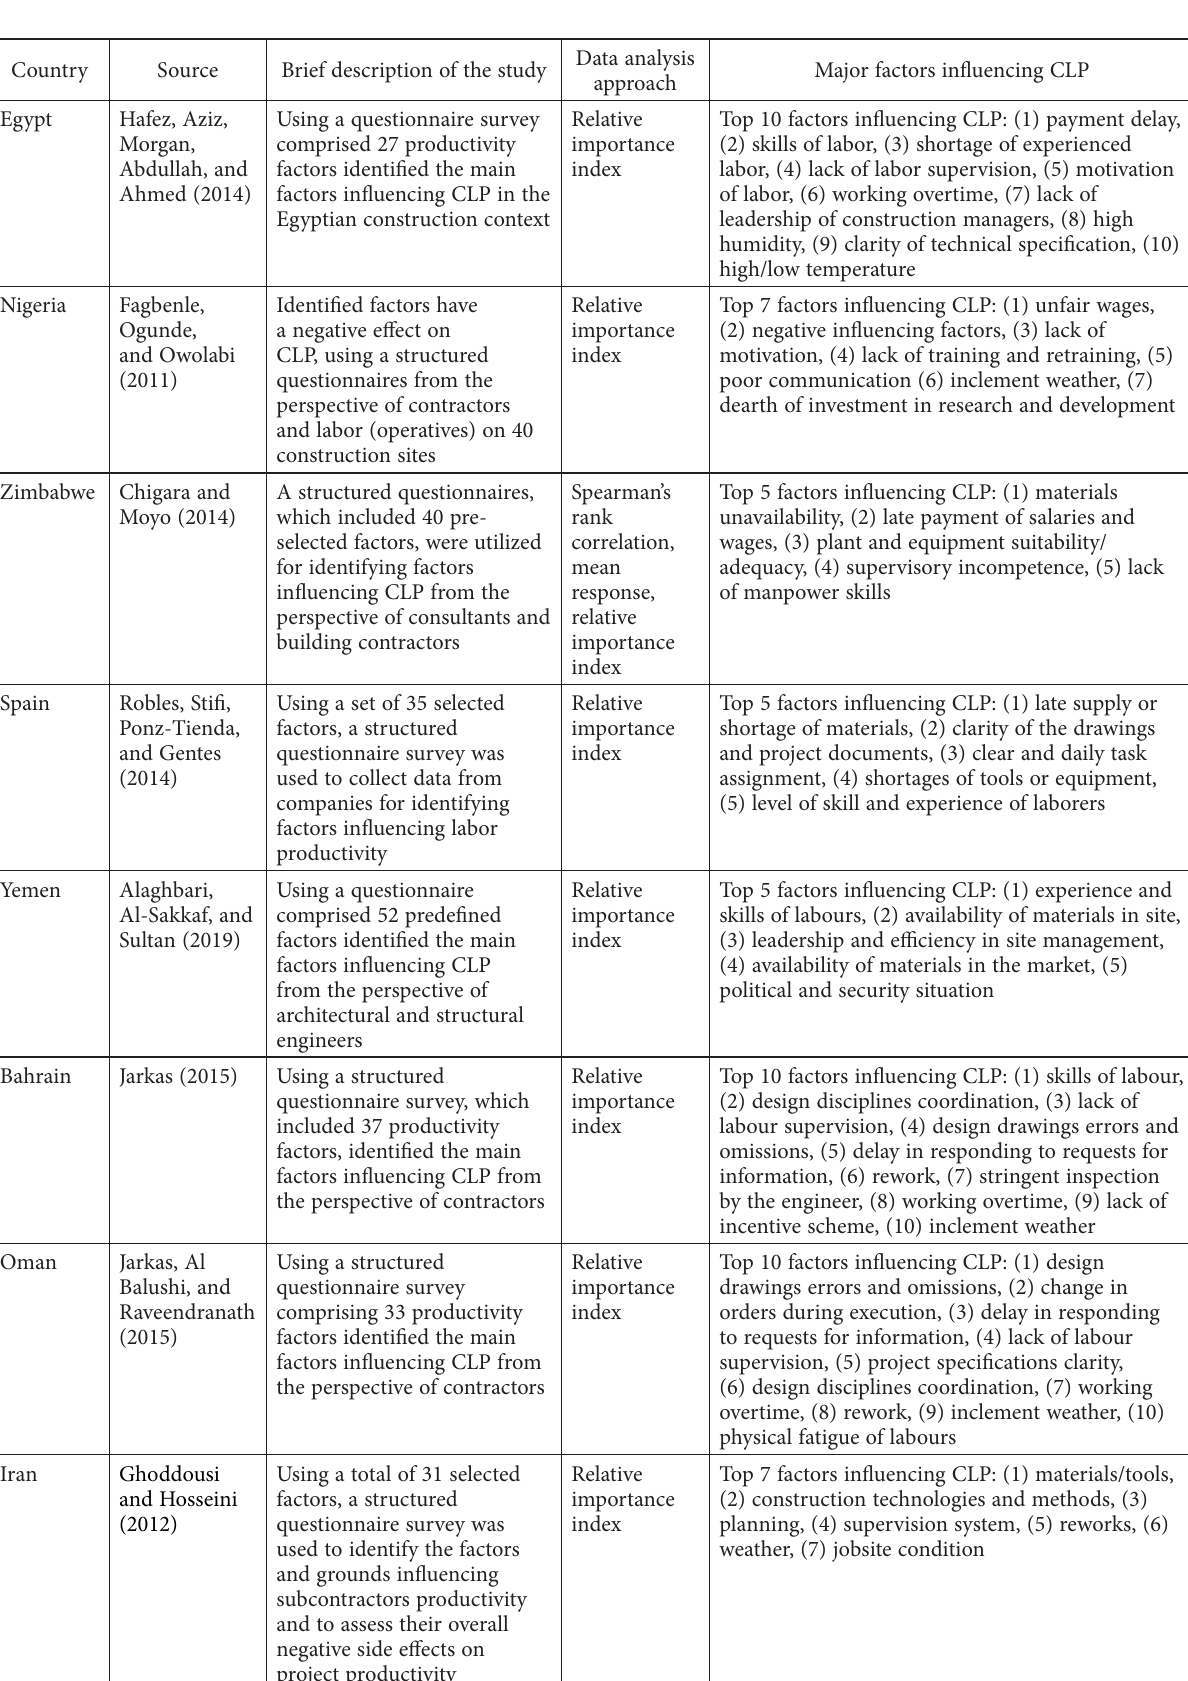
Top 7 factors influencing CLP: (1) materials/tools, (2) construction technologies and methods, (3) planning, (4) supervision system, (5) reworks, (6) weather, (7) jobsite